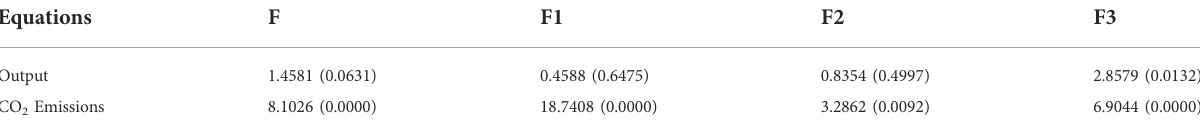
TABLE 5 Choice of transition